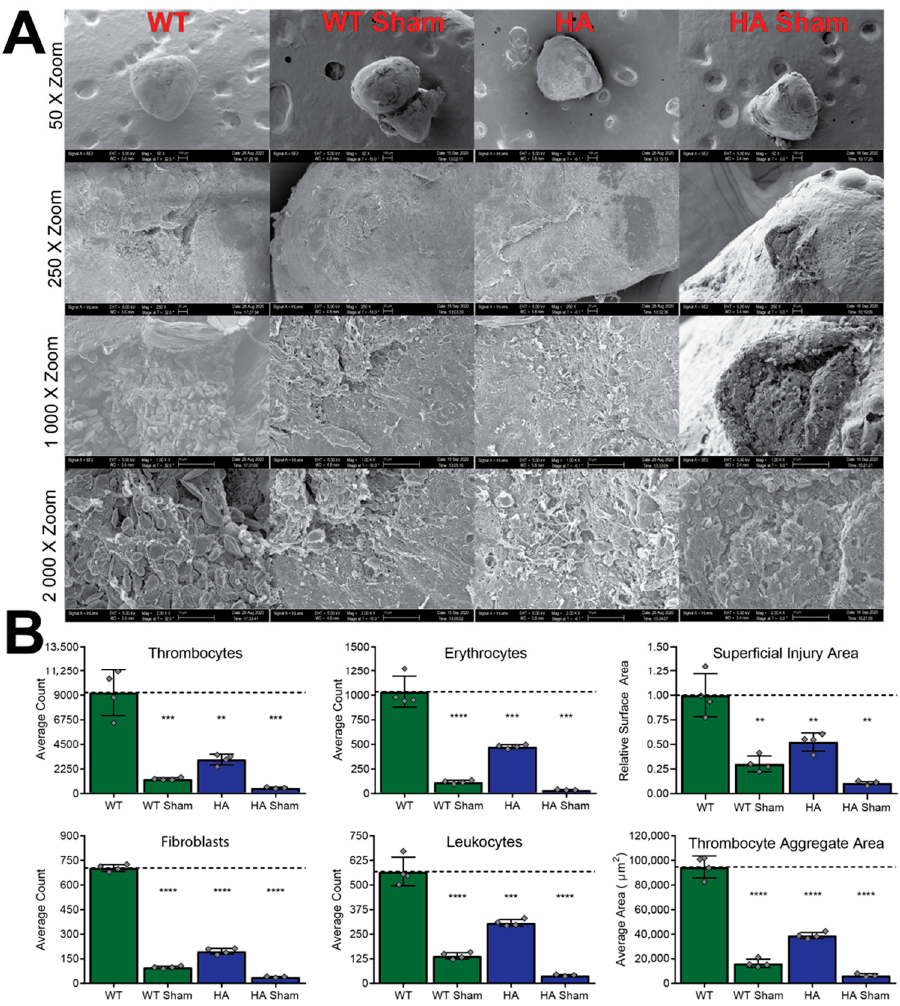
Figure 7. SEM cryoinjury imaging and associated quantifications. ( A ) Representative SEM imaging at four different zoom levels, illustrating differences between WT and hypomorphic allele (HA) groups. ( B ) Quantification of imaged parameters from panel A. **** = p -value < 0.0001, *** = p -value < 0.001, ** = p -value < 0.01.